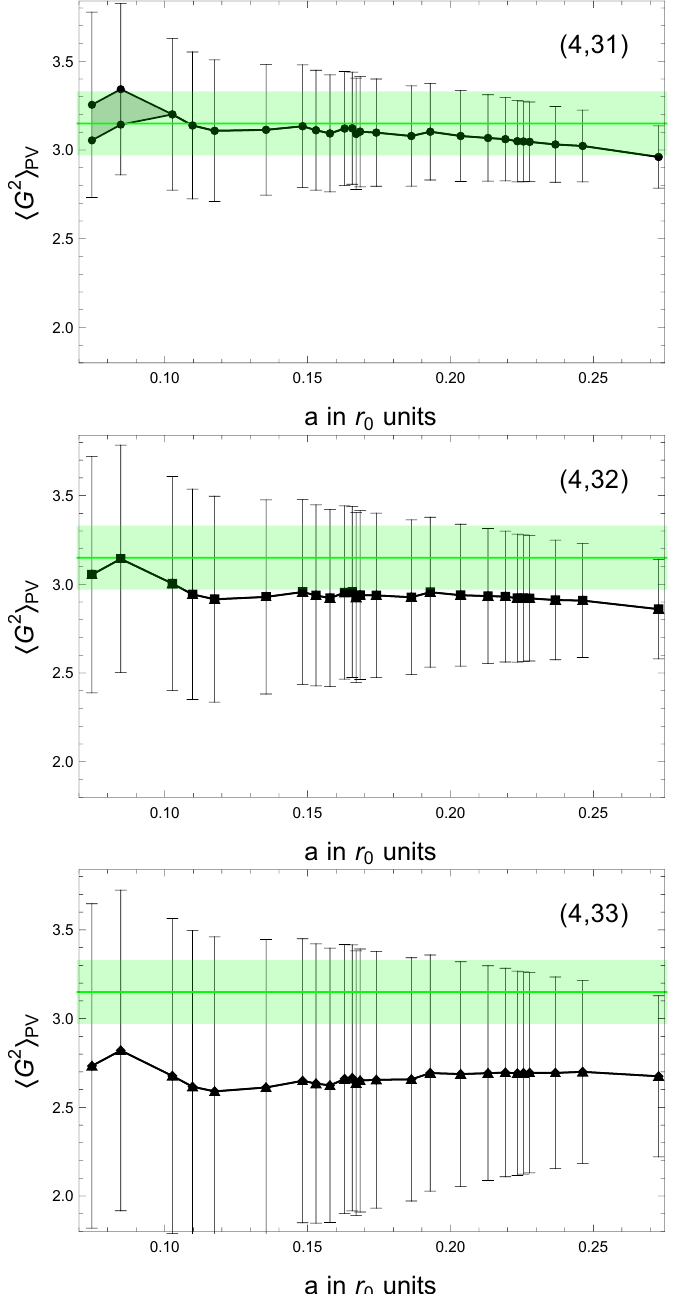
Figure 3 . Gluon condensate with hyperasymptotic accuracy (4 ; N 0 ) for N 0 = 31 (upper pannel), N 0 = 32 (middle pannel) and N 0 = 33 (lower pannel). In all cases, for each corresponding (cid:12) , we show the value obtained for the gluon condensate with the values of N P using the smallest positive (upper line) and negative (lower line) value of c that yields an integer value of N P . The error is the statistical error of the MC determination of the plaquette and of the perturbative sum combined in quadrature. The horizontal green band and its central value are our (cid:12)nal prediction, and the associated error, for the gluon condensate displayed in eq. (2.5).